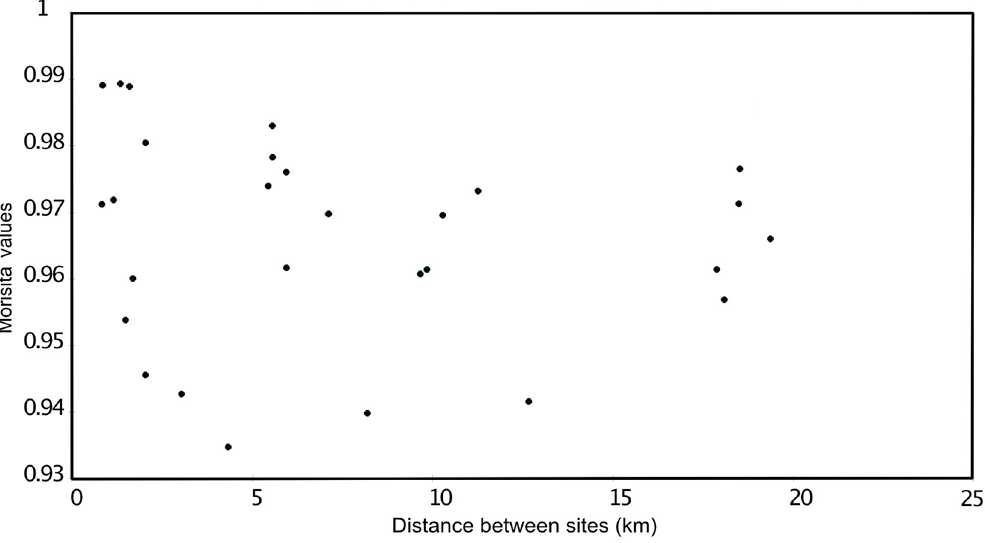
Figure 3. The Mantel test scattered plot of the distances between the studied forest sites in the NNP, Podlaskie, North-East Poland (kilometers) and the Morisita values of species similarity among sites.